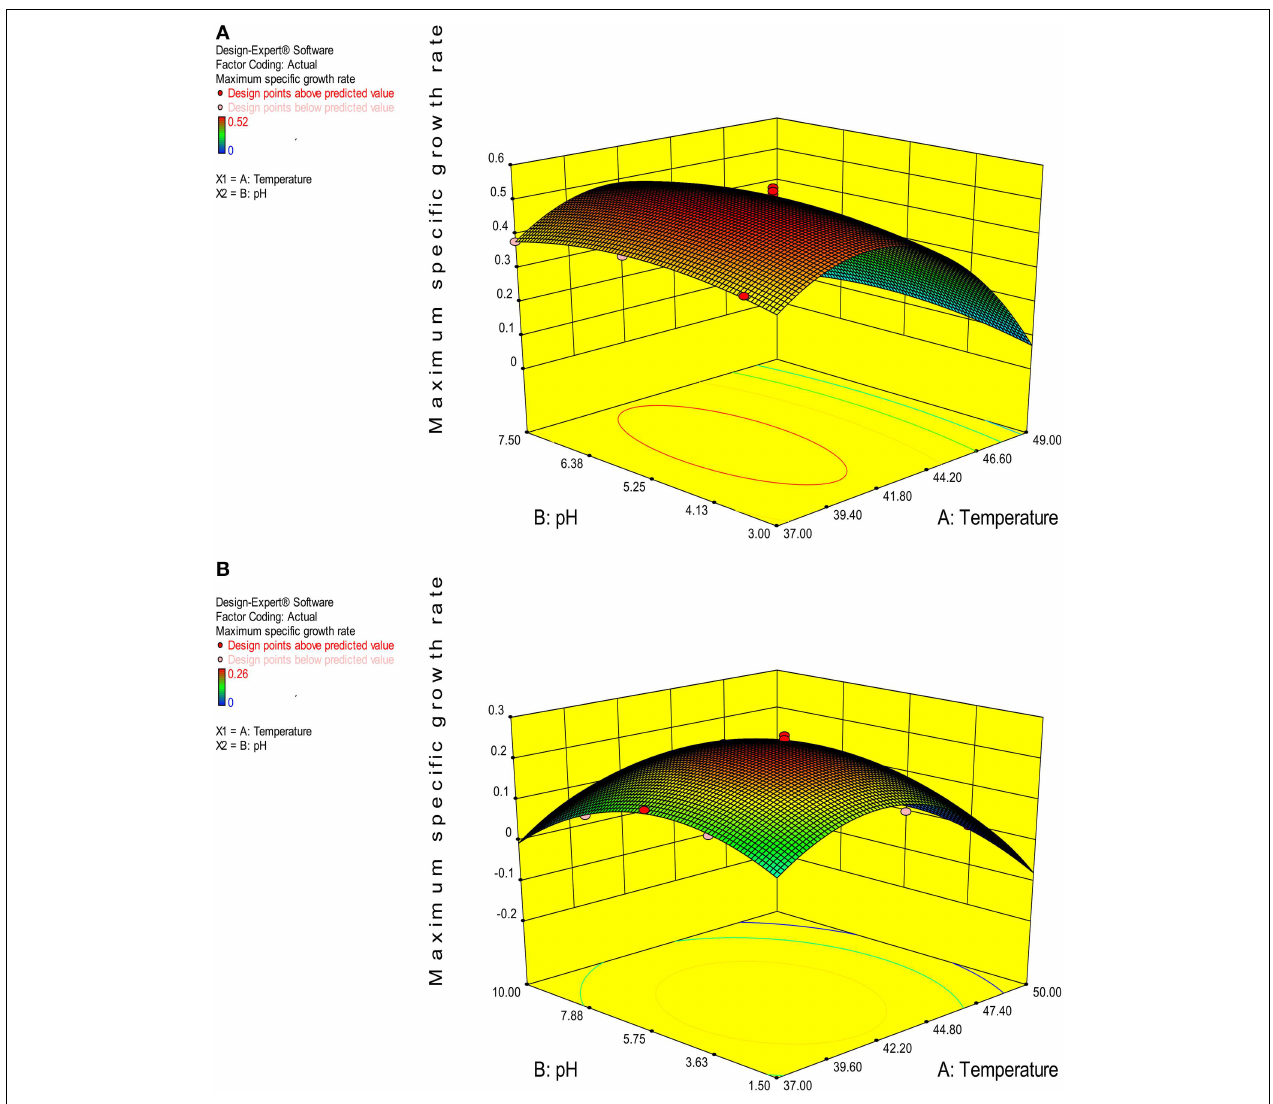
FIGURE 8 | 3-D plot of maximum specific growth rate as a function of temperature and pH (A) K. marxianus NIRE-K1 (B) K. marxianus